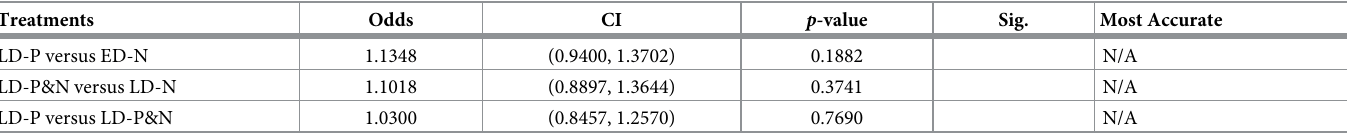
Table 9. LD : Overall accuracy analysis.